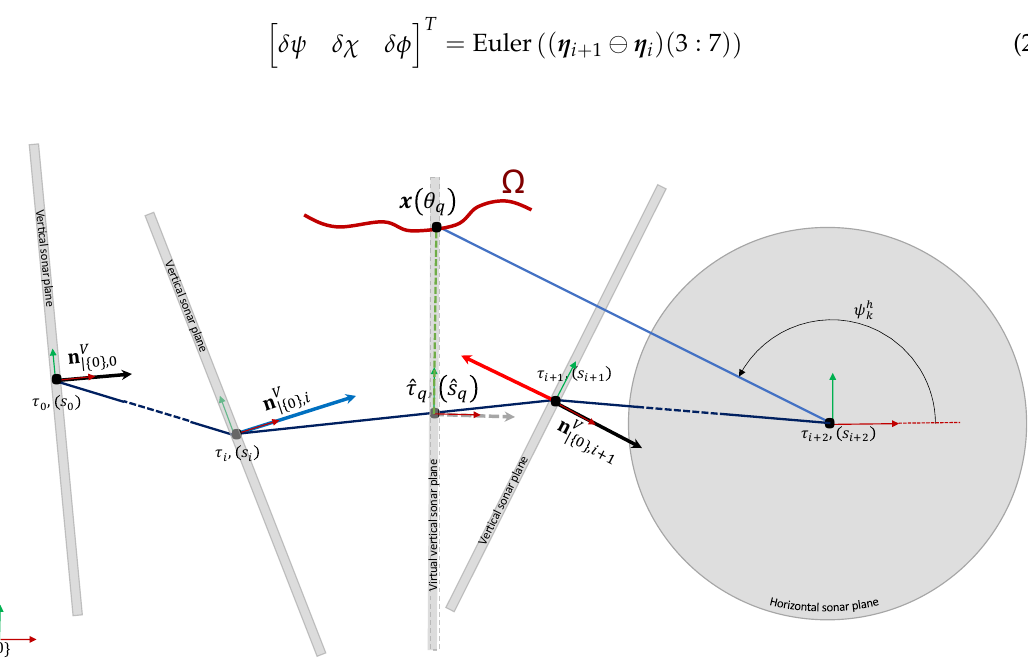
Figure 8. Segment selection for the k -th horizontal sonar measurement and q -th sample x ( θ q ) . We have represented the vertical sonar planes and rotation axis n v (resp. red) vector corresponds